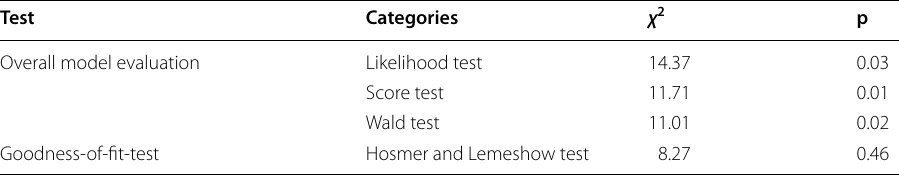
Table 5 Overall model evaluation and goodness-of-fit statistics